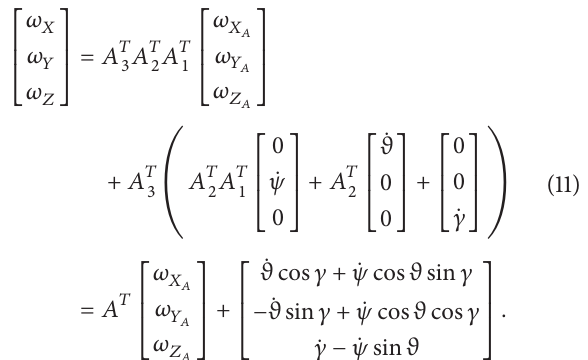
Figure 2: Sequence of rotations of the gimbals axes during platform